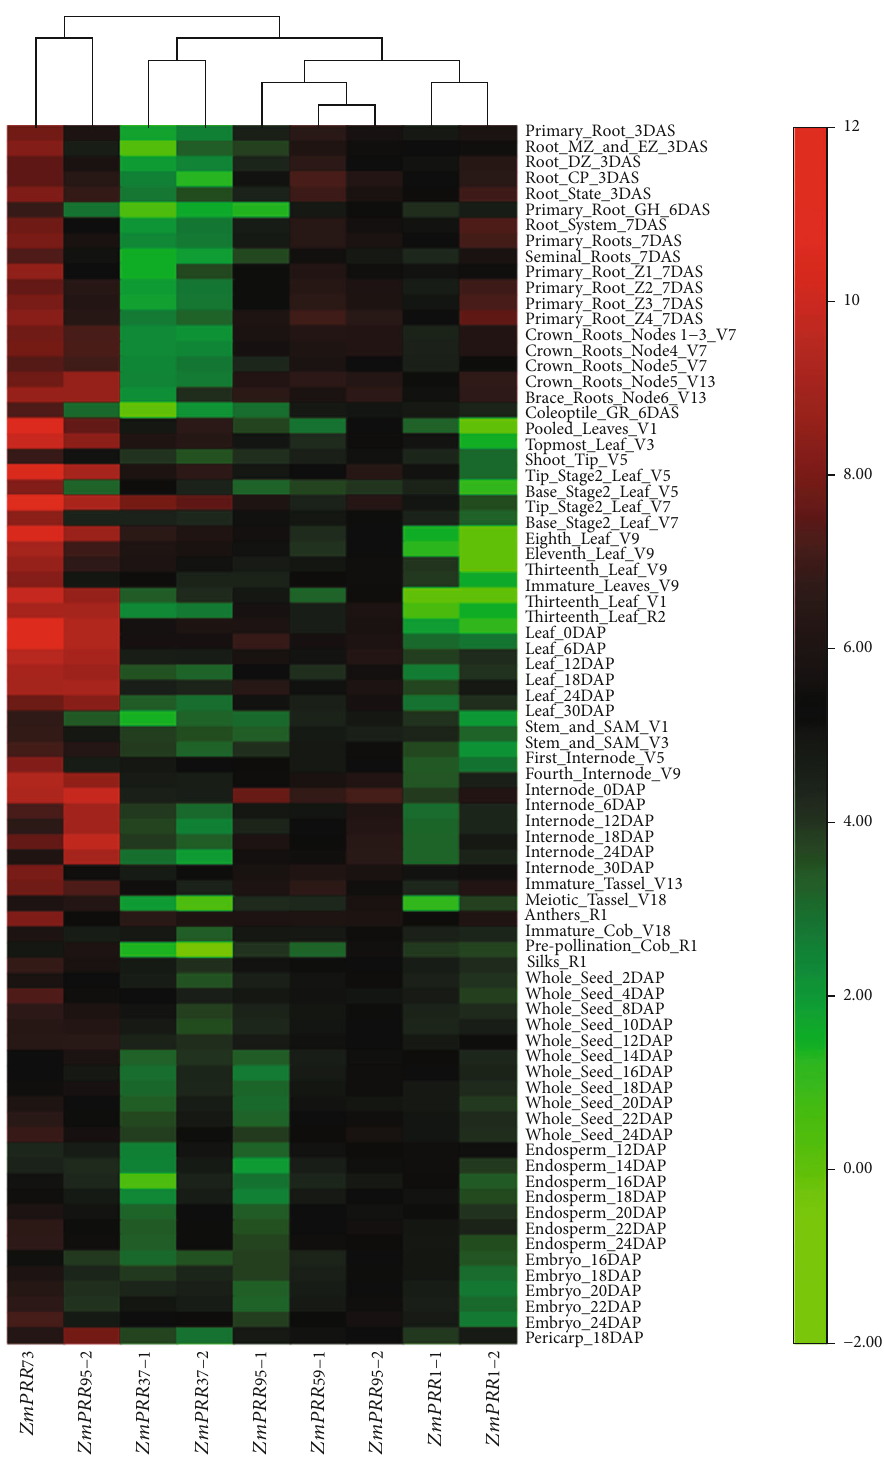
Figure 5: Expression pro fi les of ZmPRR genes across di ff erent tissues. The color scales for fold-change values are shown at the right. The expression values mapped to a color gradient from low (green) to high expression (red). The expression data were gene-wise normalized and hierarchically